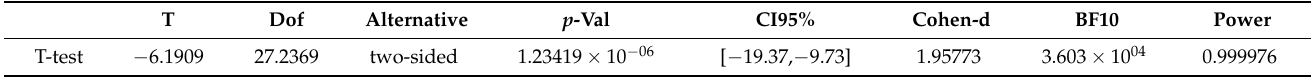
Table 5. Welch’s correction